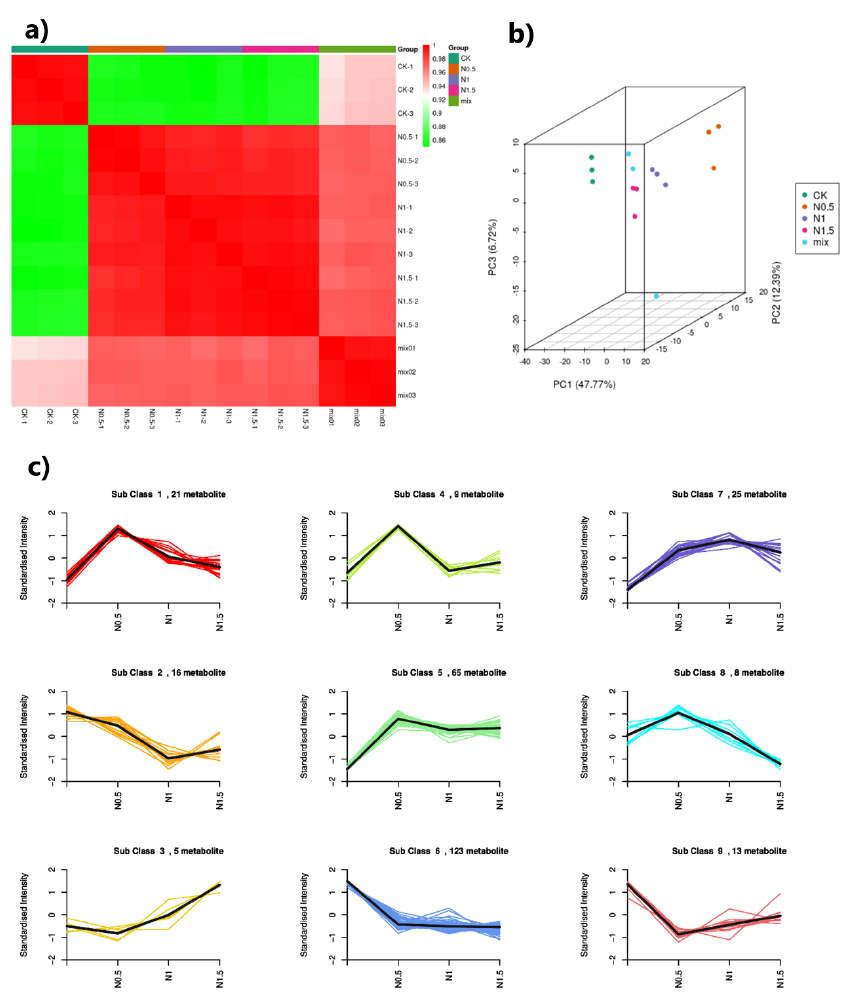
Figure 6. Quality control of metabolites identified in the experimental seedling sample extracts. ( a ) Pearson’s correlation coefficients and ( b ) principal component analysis (PCA) of metabolites extracted from cotton seedlings in the CK and treated groups after 0.5, 1, and 1.5 h treatments with NaCl; each sample was analyzed in triplicate and a quality control mix for metabolomics. ( c ) The k-means clustering of the differentially accumulated metabolites between the CK group and three treated seedling sample groups (CK: no treatment; N0.5: NaCl treatment for 0.5 h, N1: NaCl treatment for 1 h, and N1.5: NaCl treatment for 1.5 h; -1,2,3 represent replications). The X-axis represents the sample groups, and the Y-axis demonstrates the relative content of the standardized metabolites. Sub-class represents the number of the metabolite categories with the same changing trend, and the metabolite illustrates the number of metabolites in the category (metabolites within each sub-class are given in Table